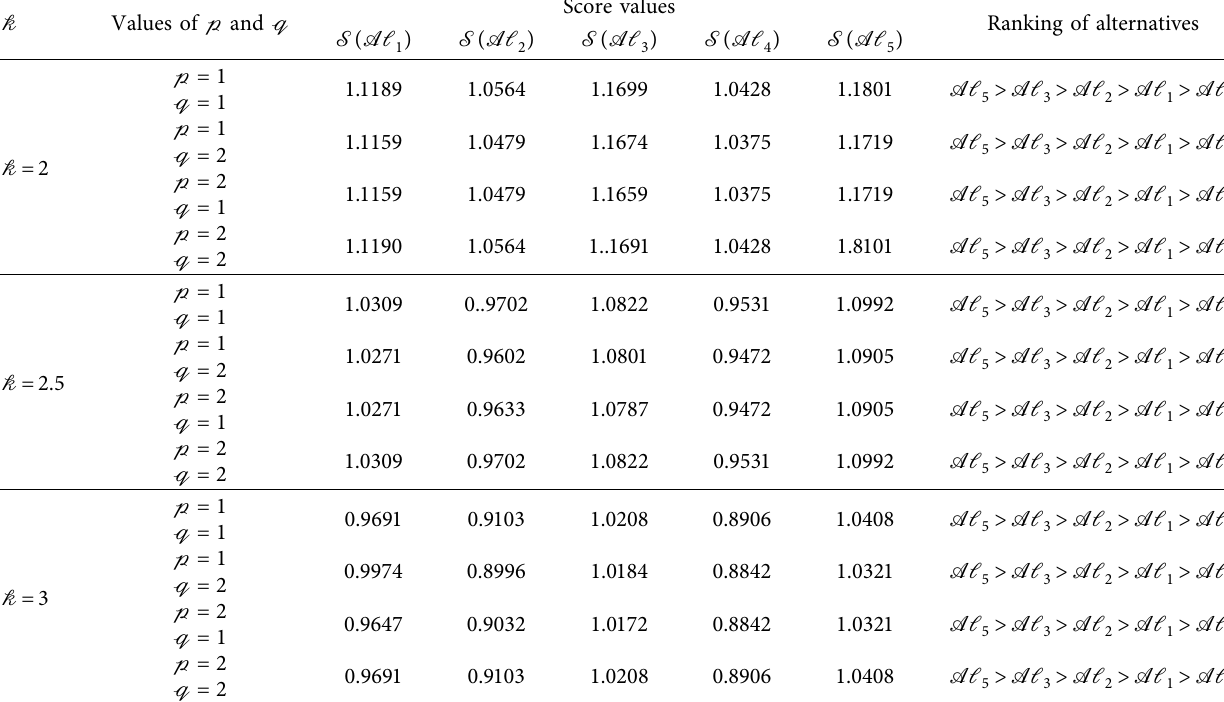
Table 7: Ranking of alternatives for different parameters by using the CIFDWGBM operator. k Values of p and